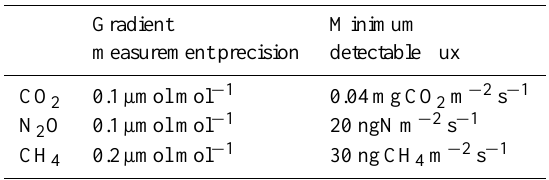
Table 4. Approximate minimum detectable fluxes achievable with the FTIR analyser using the flux gradient technique under typical turbulent diffusion conditions: diffusion coefficient 0.1–0.2m 2 s − 1 , vertical gradient scale ∼